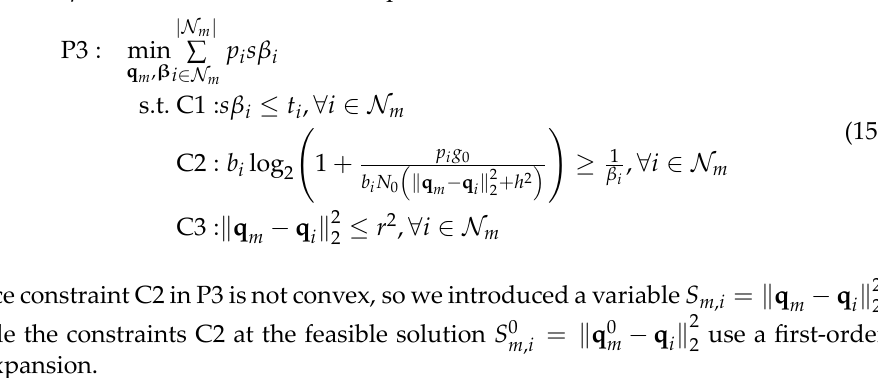
Figure 2. The interactions and dependency relationships among algorithms. Because P2 is a non‑convex problem, it is difficult to solve it directly, so we introduced slack variables β , and converted it to the P3